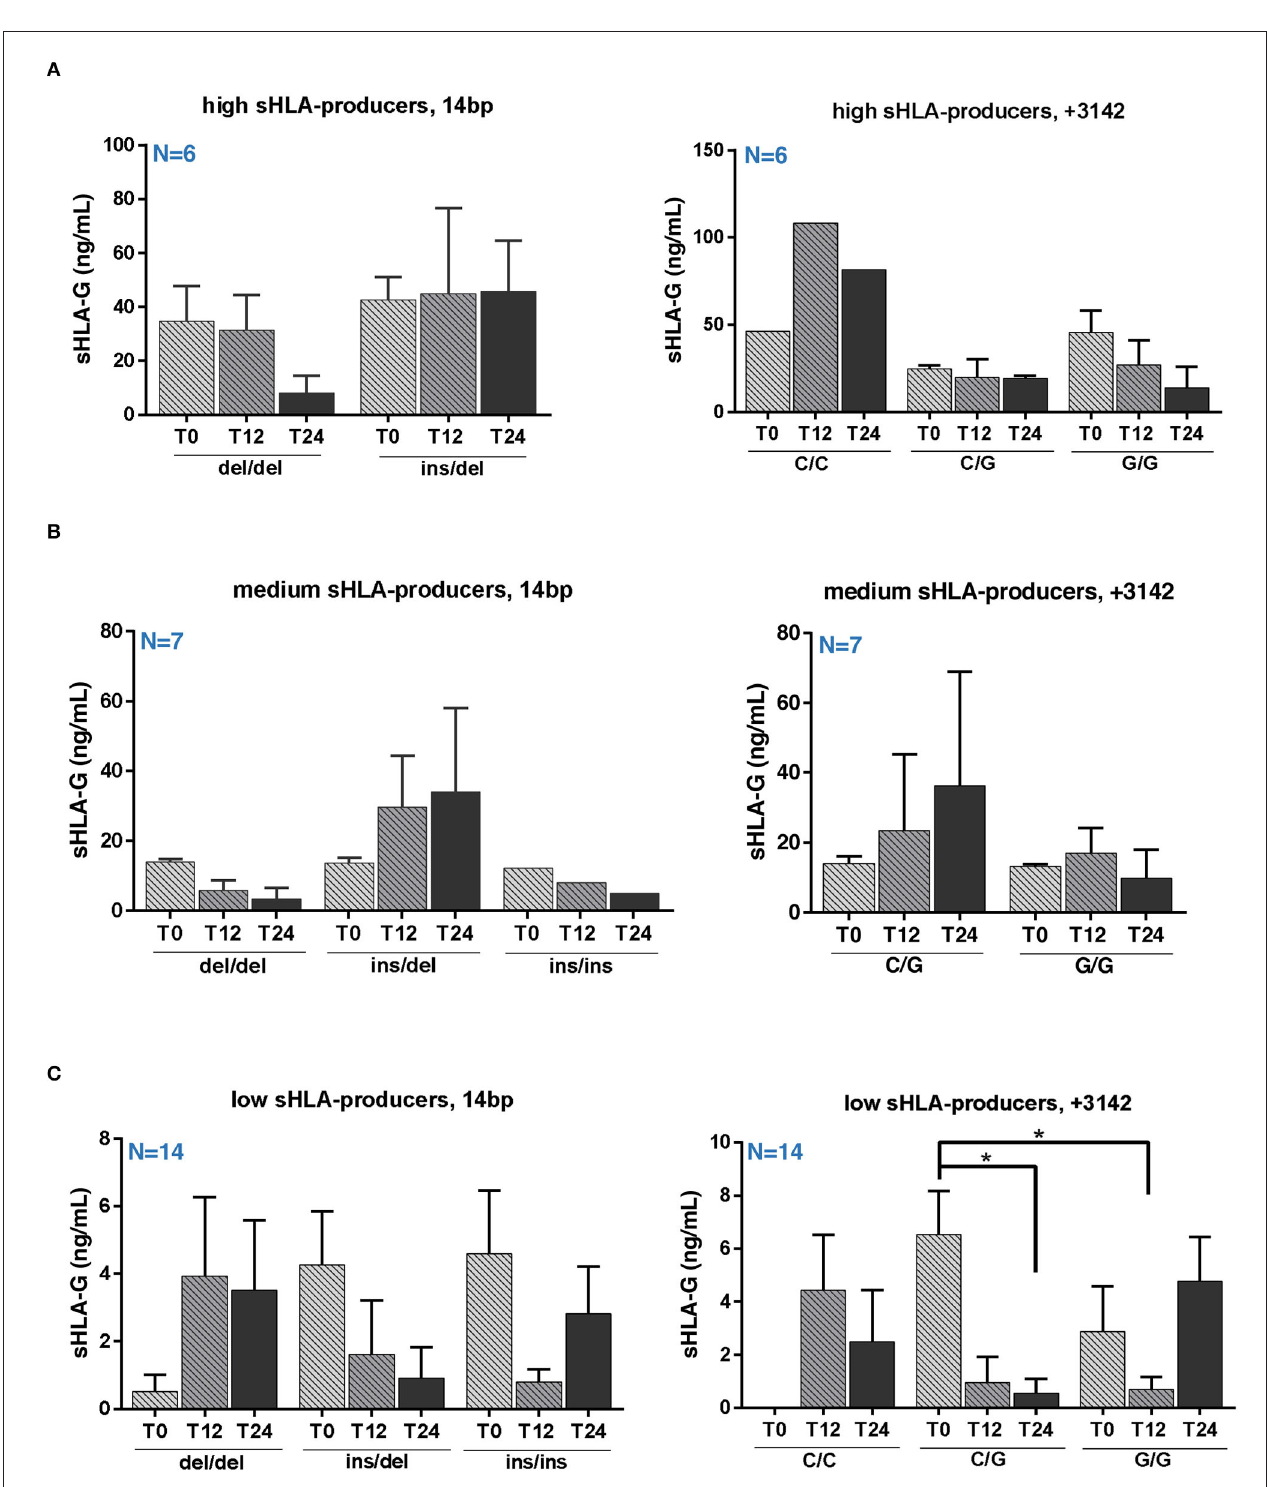
FIGURE 3 | Serum sHLA-G variation in RRMS patients during natalizumab is partially genotype-dependent. Serum sHLA-G production (ng/ml) in RRMS patients at T0, T12, and T24 of NTZ treatment divided patients into high (A) , medium (B) , and low (C) sHLA-G producers. Each group of patients is furtherly distinguished based on their HLA-G genotype (14 bp, left graphs; + 3142 bp, right graphs) and polymorphisms. Patients’ number is shown in blue for each graph. Mean ± SEM is reported; only the mean is shown for groups including a single observation. Statistical significance was determined by one-way ANOVA followed by post-hoc Tukey test (* p <